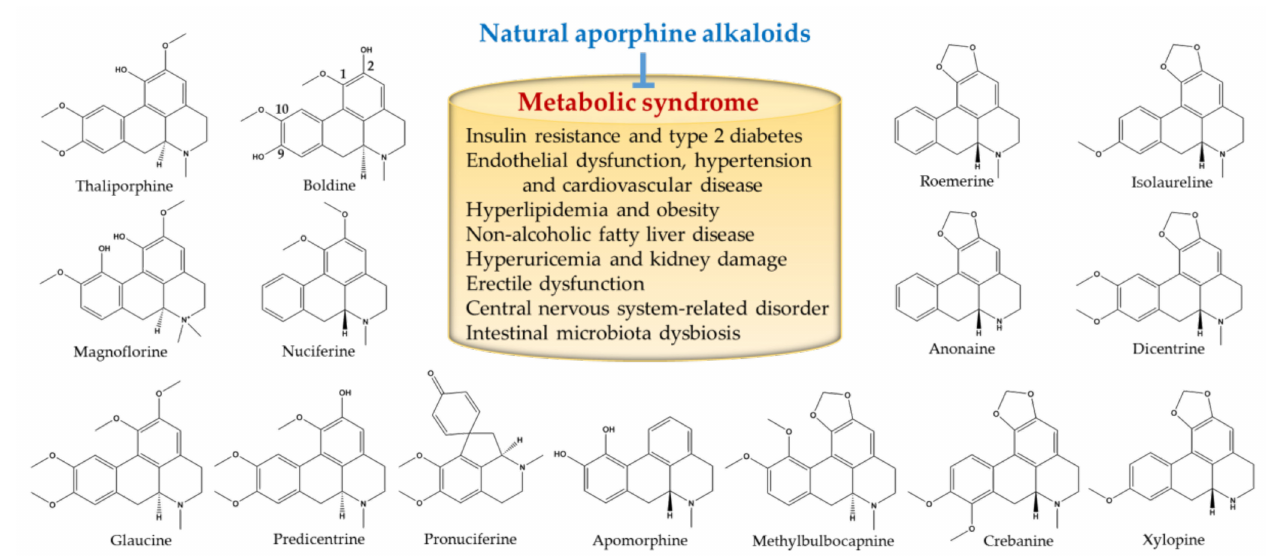
Figure 1. The structure of natural aporphine alkaloids with potential to impact metabolic